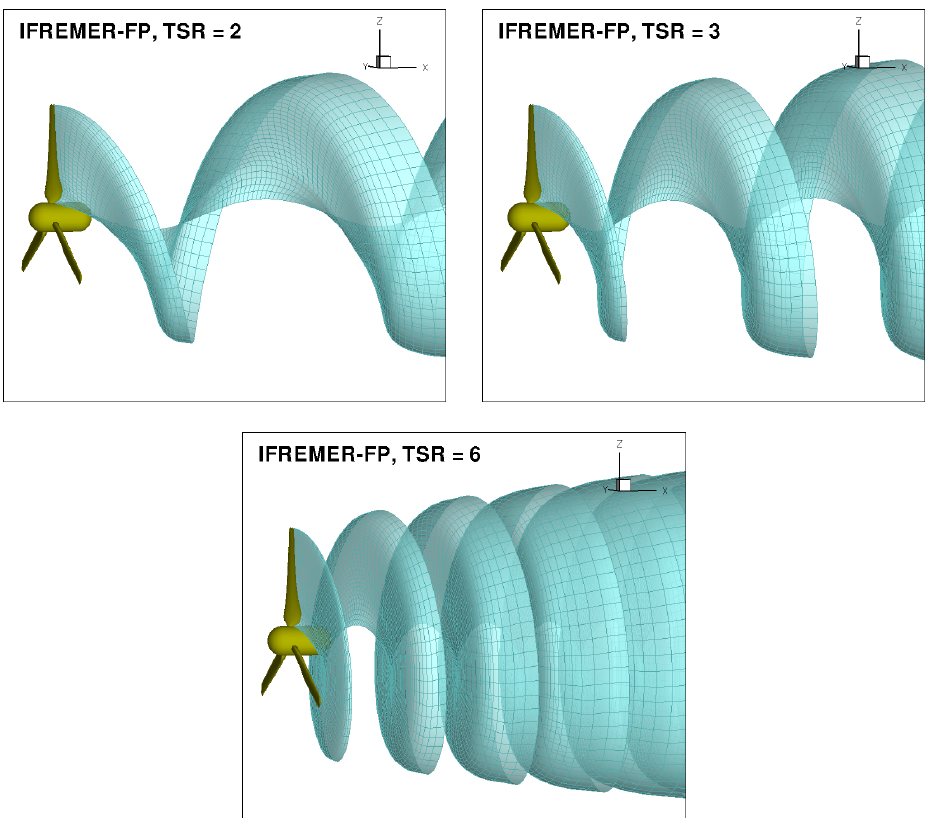
Figure 8. IFREMER-FP turbine. Trailing wake geometry of BIEM model at different operating conditions: TSR = 2 ( top left ), TSR = 3 ( top right ), TSR = 6 ( bottom